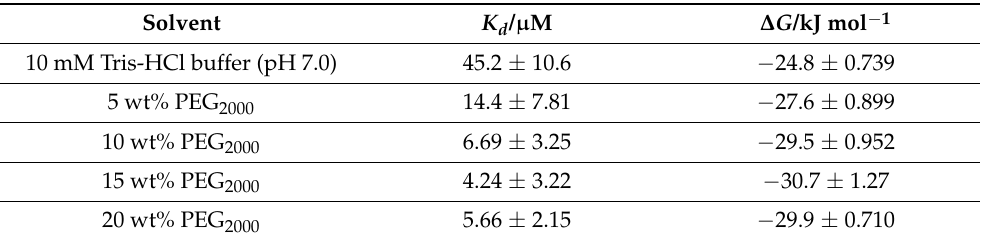
Table 1. K d and ∆ G calculated for the formation of artificial virus capsids using the ratio of the slow component.